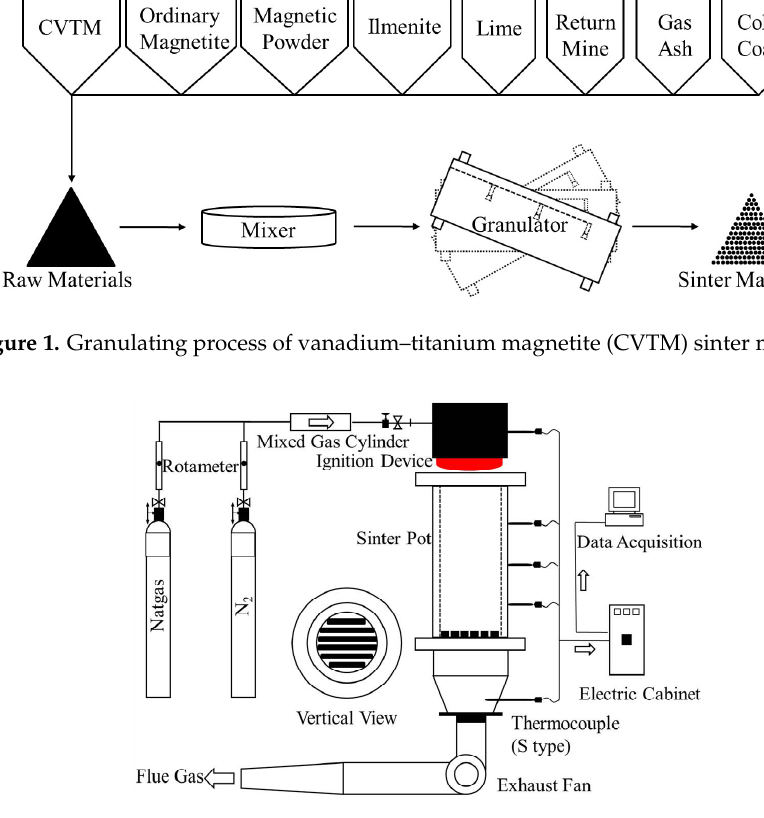
Figure 2. Schematic of sinter pot test equipment. Table 1. Parameters of CVTM sintering pot test.